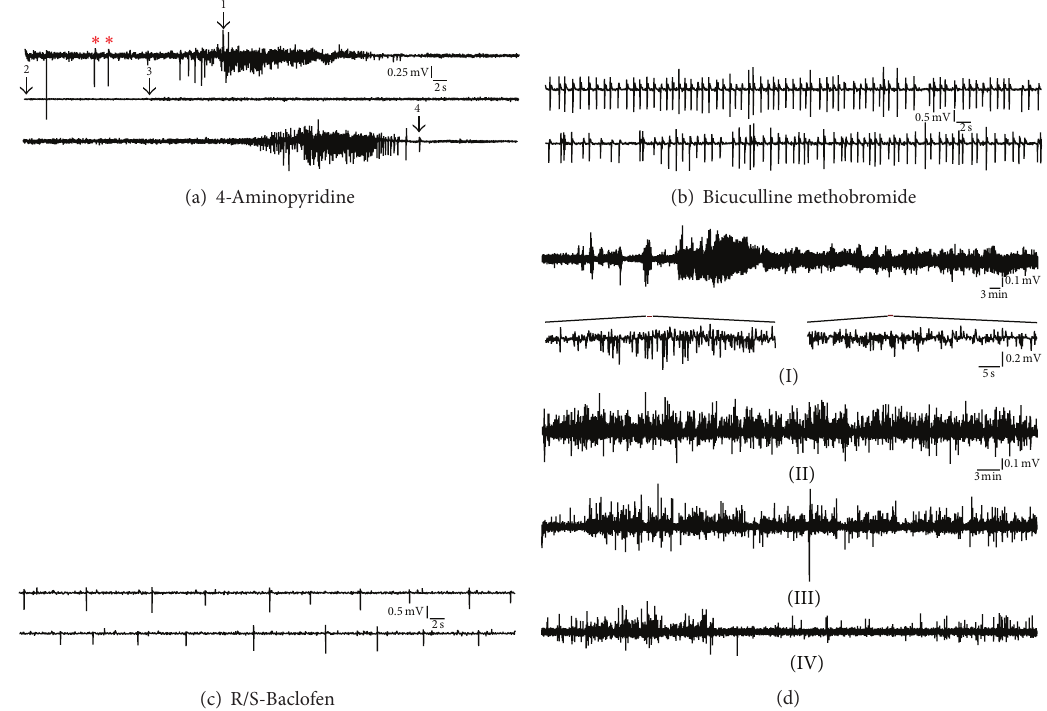
Figure 6: Pharmacological induction of epileptic discharges. (a) Surface EEG recording displaying ictal discharges after i.p. administration of 4-aminopyridine (4 AP, 10mg/kg). Sporadic spikes (T) evolve into a transitory episode of continuous spiking (1), resulting in an EEG depression (decreased amplitude, 2-3). Shortly after this period a second spike-train concomitant to the development of a generalized tonic- clonic seizure with wild running and jumping becomes apparent which finally results in a tonic extension of the hindlimbs (4) and death. The remaining tiny signal following brain death represents an ECG (R-spike) contamination. (b) After i.p. administration of bicuculline methobromide(BMB,10mg/kg)miceshowtrainsofcharacteristicspikesandspikewaves.(c)Administrationofbaclofen(20mg/kg)resulting in sporadic occurrence of spiking activity. (d) Intrahippocampal electroencephalographic (EEG) recordings following i.p. administration of KA (30 mg/kg). (I): deep CA1 recording from a C57Bl/6J mouse for 2 h immediately after KA administration. At 30mg/kg KA contiguous hippocampal seizure activity is observed occasionally interrupted by postictal depression (arrows). Ictal discharges are characterized by spike and/or spike-wave activity (see insets) in the delta- and theta-wave range (4–8 Hz). (II–IV) At days 1, 3, and 5 after injection 1h CA1 EEG recordings illustrate declining but still continuous ictal discharges related to neuronal excitotoxic degeneration (with permission from [96,